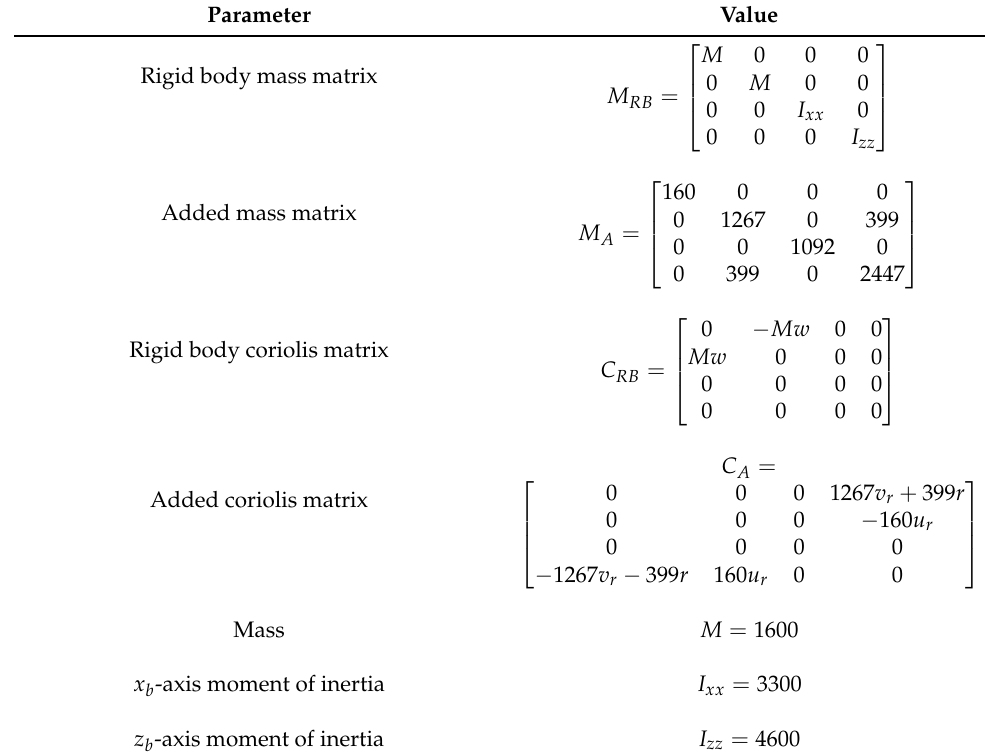
Table 2. Sailing physical